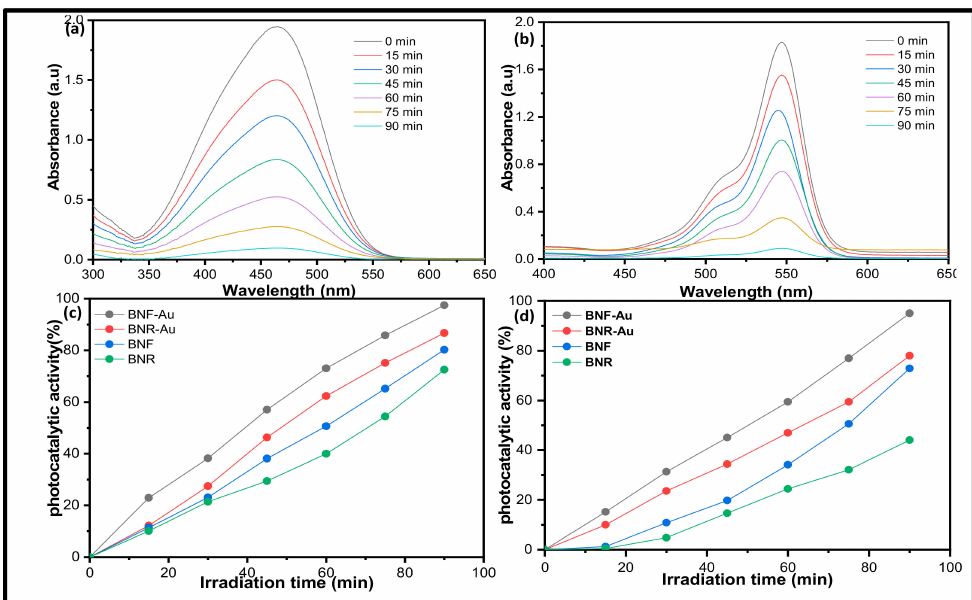
Figure 4. Representative absorbance changes of MO ( a ), RhB ( b ) using BNR-Au and the percentages degradation efficiency by the nanocrystals and corresponding gold decorated analogues for MO ( c ) and RhB ( d